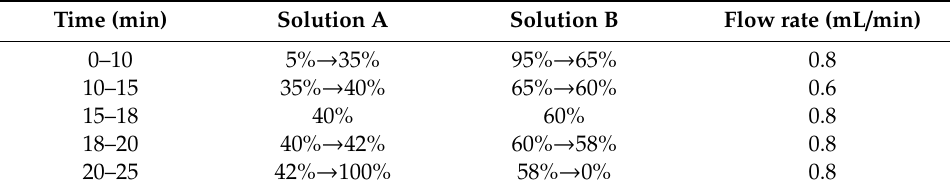
Table 4. The composition of the gradient (A:B) for luteolin-7- O